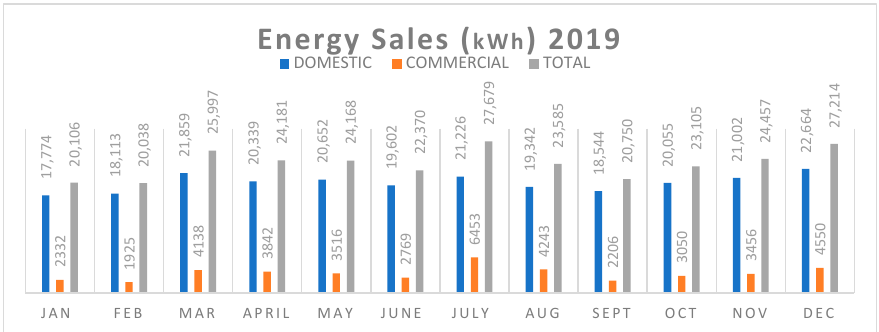
Figure 3. Energy Sales January–December 2019.